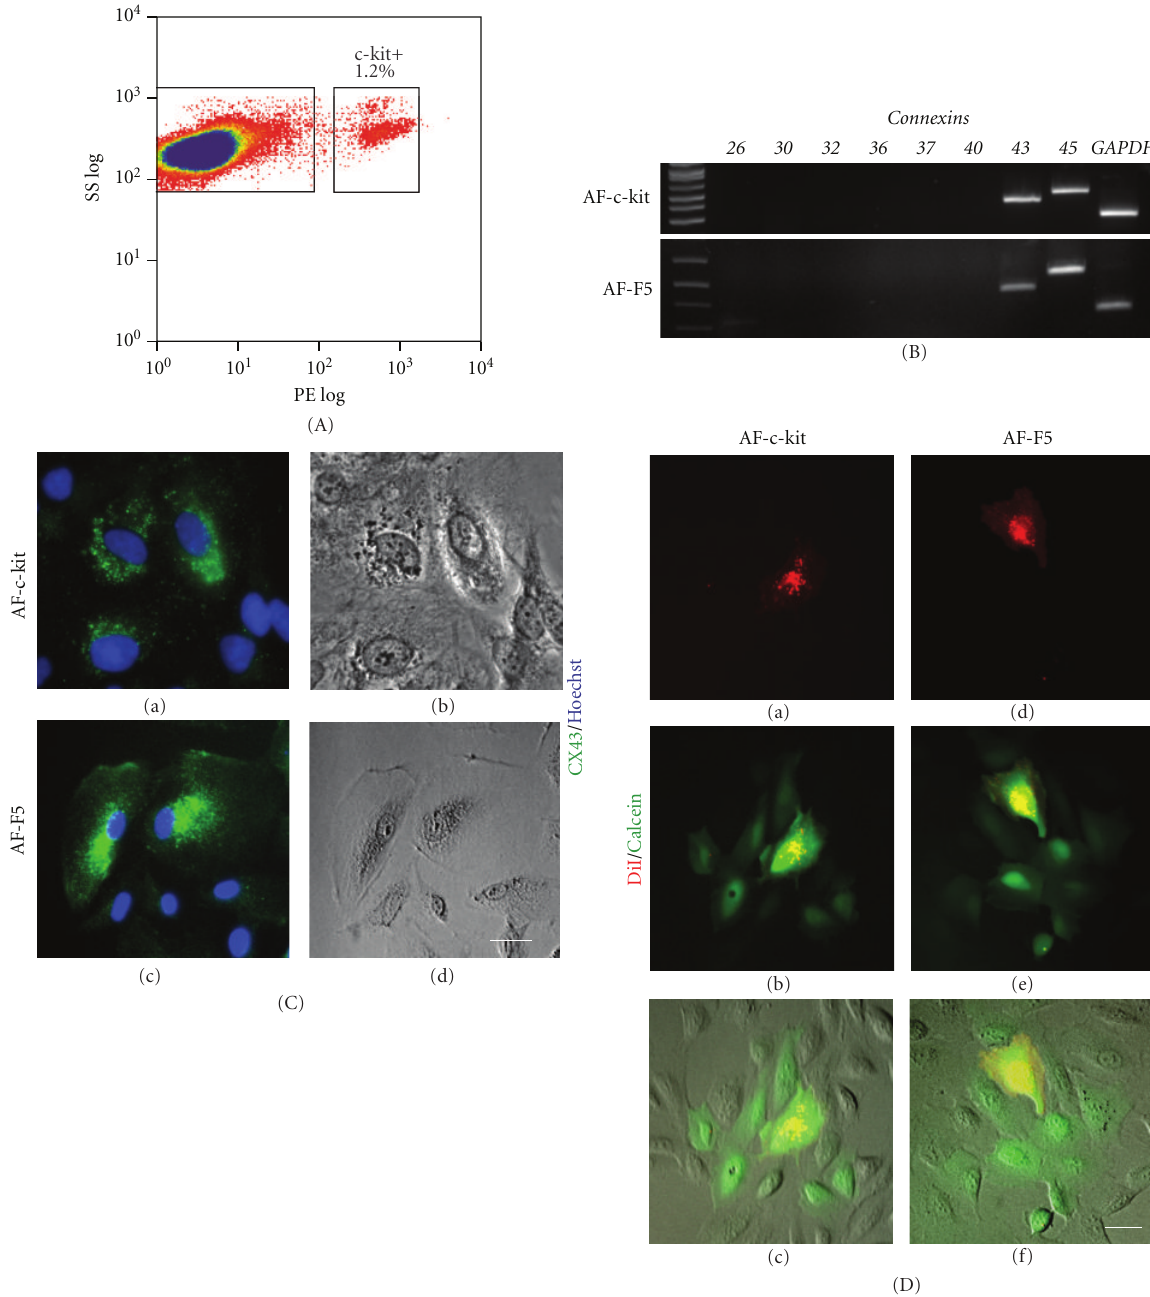
Figure 2: Connexin expression in c-kit-positive and single-cell-derived AF clones. (A) c-kit-positive AF cells were obtained by fluorescence activated cell sorting (FACS). (B) RT-PCR analysis of connexin ( CX ) expression in c-kit-positive (AF-c-kit) and single-cell-derived (AF-F5) AF clones. GAPDH transcript was used as an internal control. (C) Immunocytochemistry confirmed the expression of CX43 (green) in AF- c-kit and AF-F5 cultures. Hoechst was used as a counter-stain (blue). (b) and (d) represent the corresponding phase contrast images. Scale bar: 25 μ m. (D) AF donor cells were preloaded with DiI (red) and calcein (green) and plated as single cells on cultures of AF cells. Calcein transferred from the donor AF cell to neighbouring cells, confirming the formation of functional gap junctions among AF-c-kit cells as well as AF-F5 cells within 4 hours. Scale bar: 50 μ